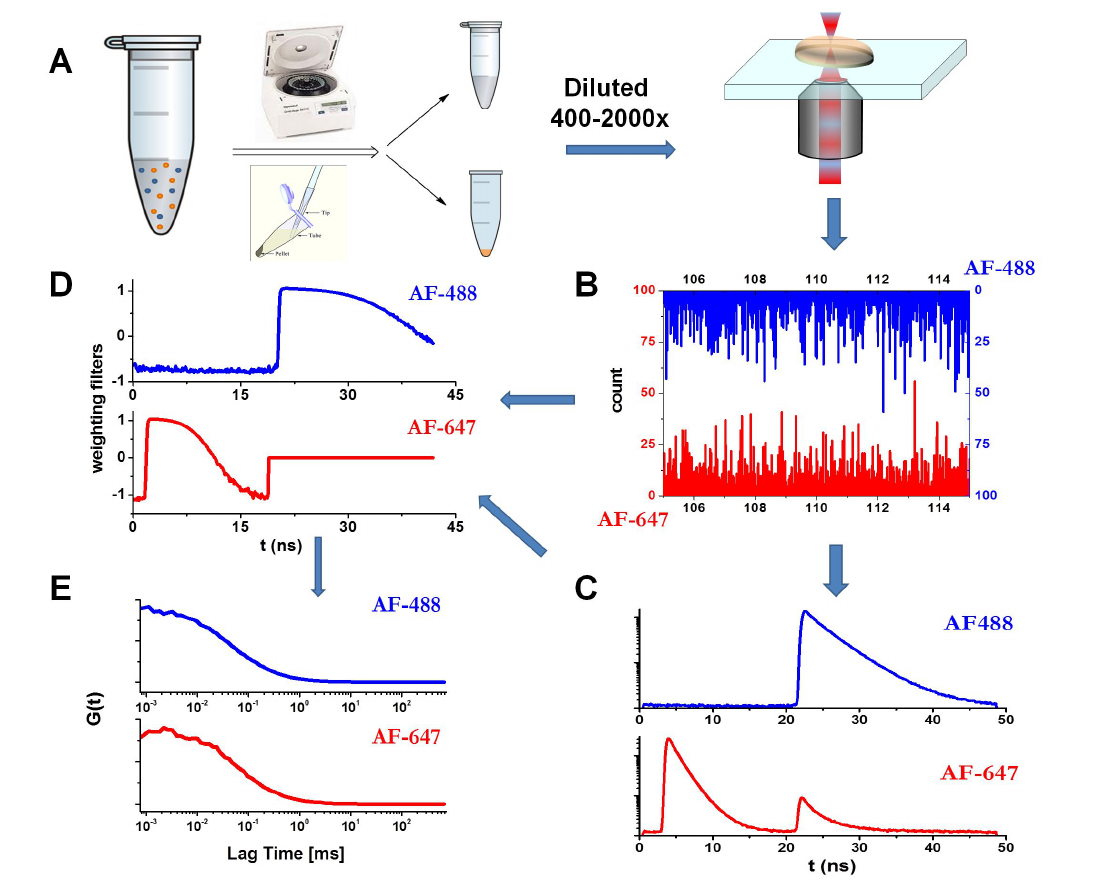
Figure 1. Schematics of the Pulsed Interleaved Excitation-Fluorescence Lifetime Correlation Spectroscopy (PIE-FLCS) measurement. ( A ) Protocol for the PIE-FLCS measurements. ( B ) Example of fluorescence traces in the AF488 and AF647